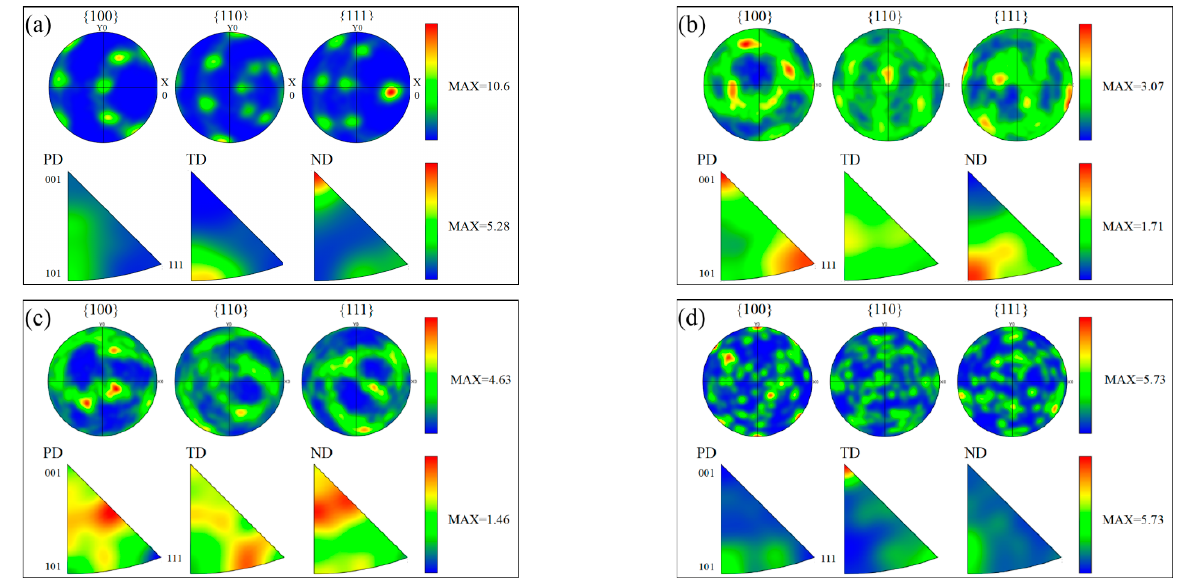
Figure 6. The pole figures and inverse pole figures of ( a ) SZ-1; ( b ) SZ-2; ( c ) SZ-3 and ( d ) BM.